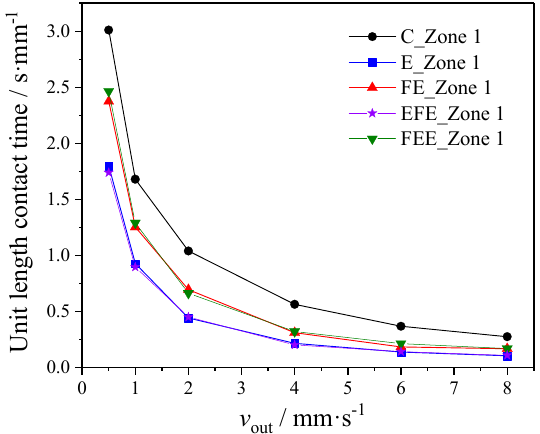
Figure 8. Variations of particle contact time with v out at Zone 1 of different tubes ( d p = 1.72 mm). The variations of local heat transfer coe ffi cients of particle flow with v out for di ff erent tubes